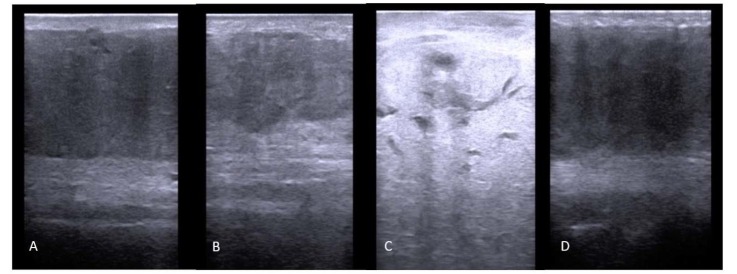
Ultrasound images of a mammary gland of a healthy sow (A) and from sows with from severe udder oedema (B-C). These images show thickened dermal and subdermal tissues (B, C), hyperechoic lobuloalveolar tissue (B, C) with enlarged blood vessels (C) and severe shadowing (D) (Björkman et al., 2017a, 2018a).